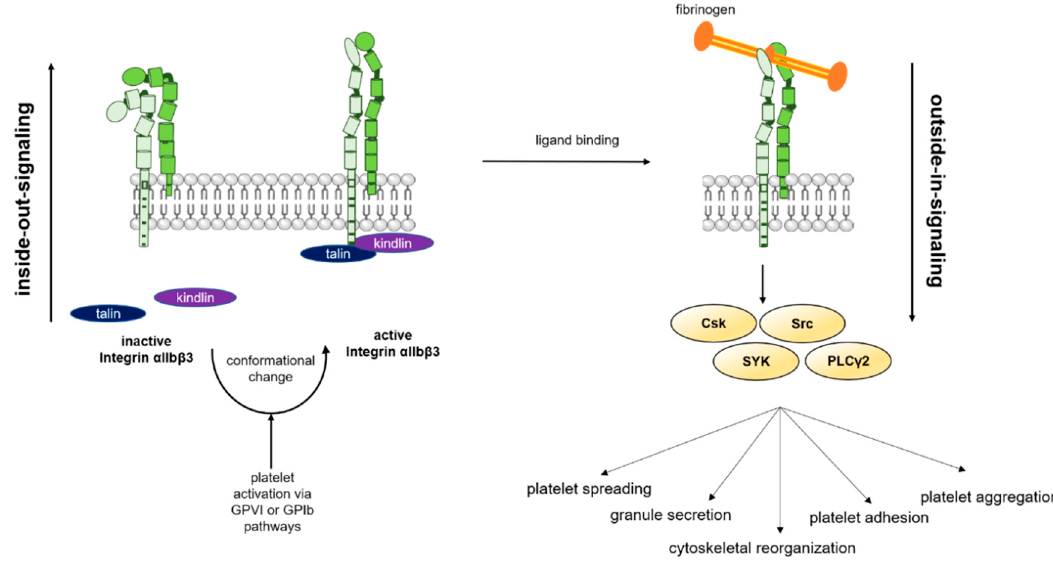
Figure 3. Inside-out- and outside-in-signaling of integrin α IIb β 3 . In resting platelets, integrin α IIb β 3 is in an inactive conformation that prevents ligand binding. However, an initial activation of platelets (e.g., via GPIb or GPVI signaling) leads to binding of cytosolic kindlin and talin. This binding induces a conformational change of integrin α IIb β 3 that allows the binding of fibrinogen and other ligands. The process which induces the conformational change of integrin α IIb β 3 is called inside-out signaling. Binding of a ligand like fibrinogen to the extracellular domain of integrin α IIb β 3 triggers a signaling cascade through various kinases. This amplifies di ff erent platelet processes such as spreading, granule secretion and aggregation. The process of extracellular ligand-induced activation of integrin α IIb β 3